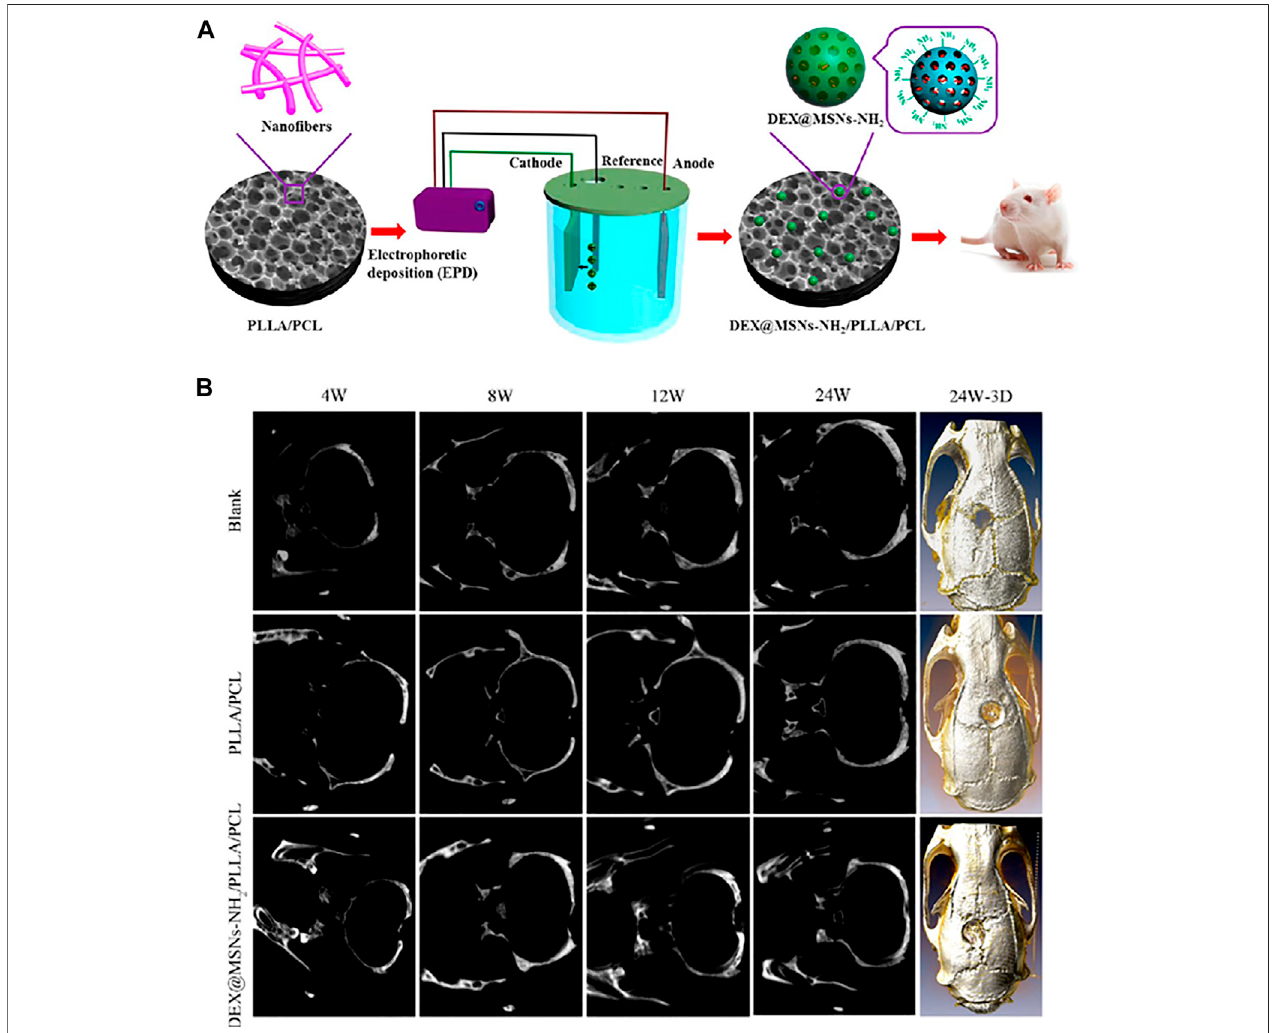
FIGURE 5 | (A) Schematic illustration for the fabrication of DEX@MSNs-NH2/PLLA/PCL composite scaffolds; (B) Micro-CT evaluation of SD rat calvarial bone defects. Images of plain micro-CT scanning at 4, 8, 12, and 24 W (left) and 3D micro-CT reconstruction after 24 W (right) of implantation of the blank and the PLLA/PCL and DEX@MSNs-NH 2 /PLLA/PCL scaffolds. Reprinted with permission from Qiu et al. (2016). Copyright © 2016 American Chemical Society.